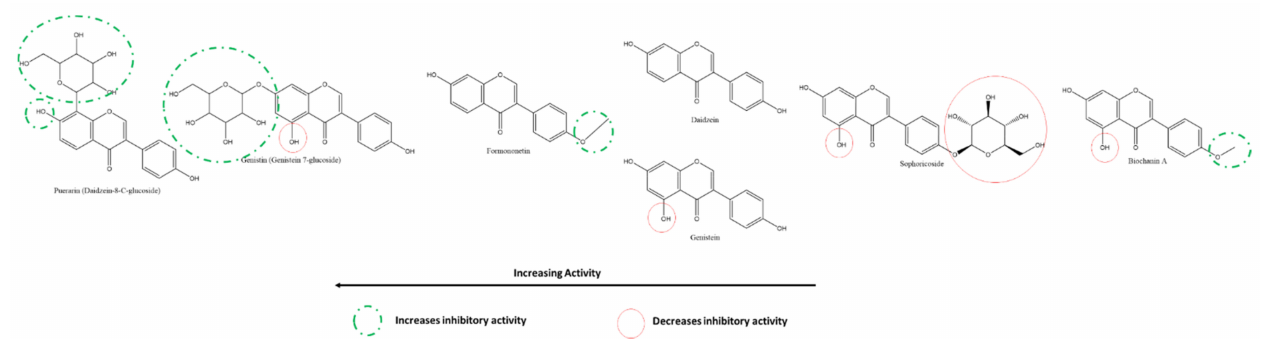
Figure 16. Structure–activity relationships of various isoflavones against SARS-CoV-2 3CLpro, adapted from the experiments of [117,118] using in vitro FRET assays. Substitutions and groups that result in an increase/decrease in inhibitory activities are shown in red and green, respectively.